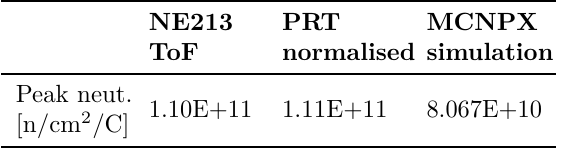
Table 3. Integral values of QM neutrons at the CLID irradiation